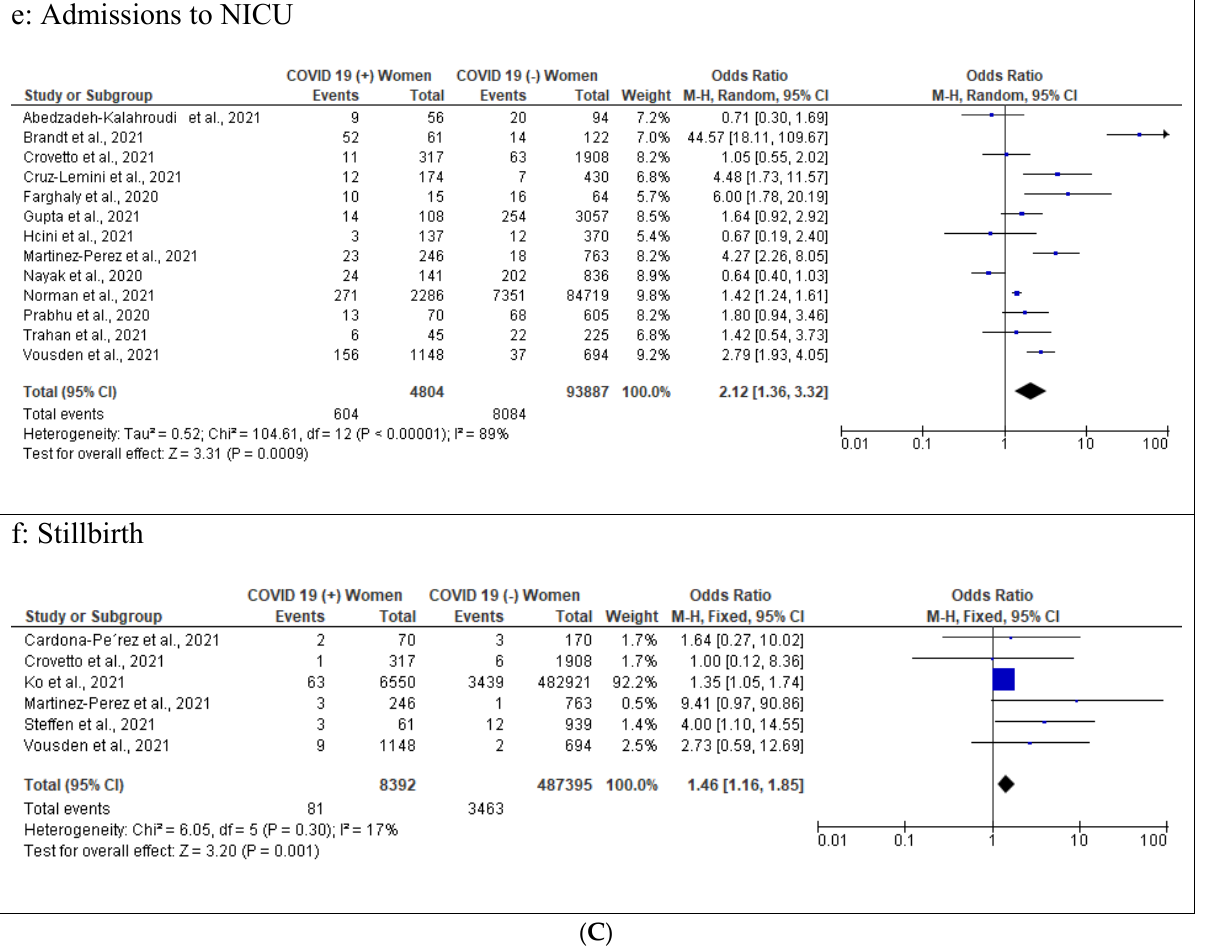
Figure 4. ( A ) Forest plots of adverse maternal outcomes. a, Maternal death. b, Preeclampsia. c, Cesarean delivery. d, Miscarriage/abortion. e, PROM/PPROM. f, Operative vaginal birth. PROM, Pre-labor rupture of membrane. PPROM, Preterm pre-labor rupture of membrane. ( B ) Forest plots of adverse fetal outcomes. a, Fetal distress. b, Intrauterine death. ( C ) Forest plots of adverse neonatal outcomes. a, Preterm birth. b, Low Birth weight. c, Fifth minute Apgar score <7. d, Neonatal death. e, Admissions to NICU. f, Stillbirth. NICU, Neonatal intensive care unit.